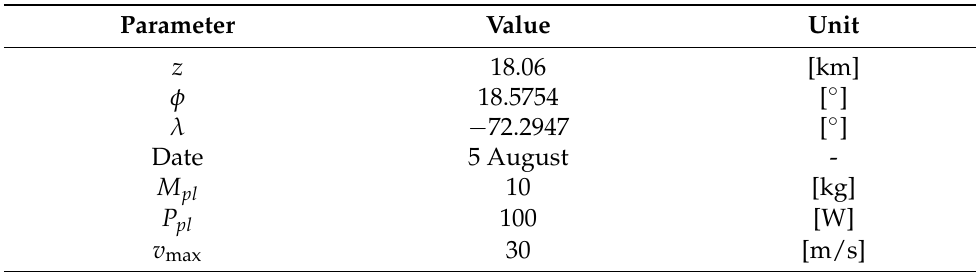
Table 9. HAPS mission design specifications for operation at 18.06 km altitude above Port-au- Prince,